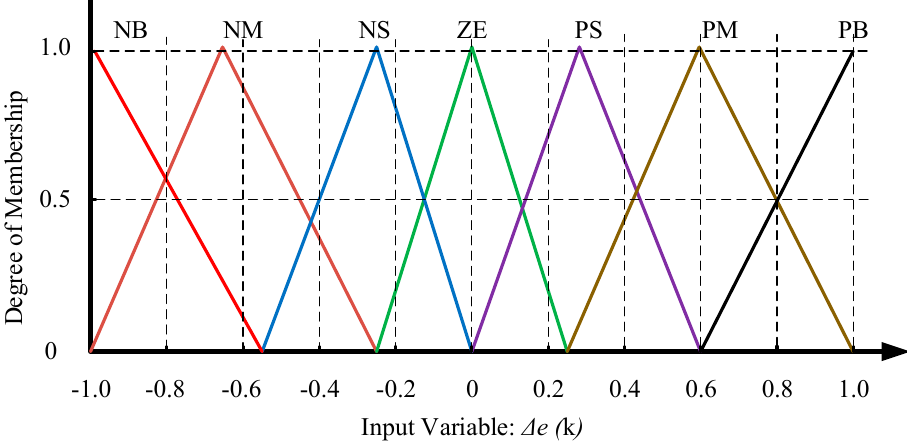
Figure 5. Membership function change in error.